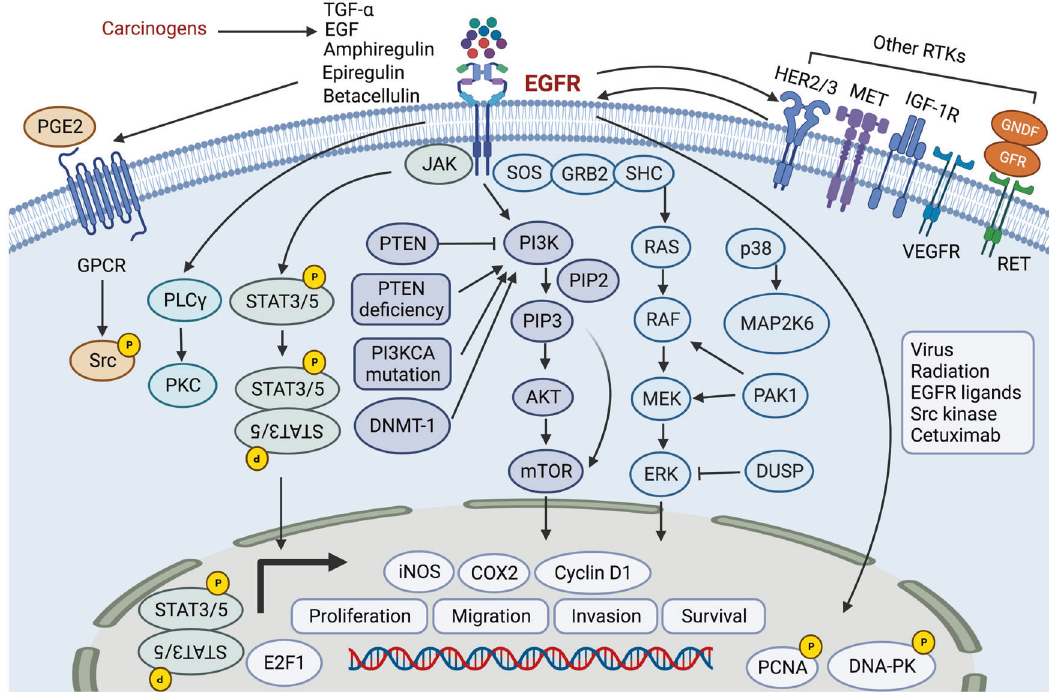
Fig. 2 The EGFR signaling pathway, PI3K/AKT/mTOR pathway, MAPK pathway, STAT pathway, and MET pathway in head and neck cancer. EGFR epidermal growth factor receptor, TGF- α transforming growth factor-alpha, EGF epidermal growth factor, RTKs receptor tyrosine kinases, HER2/3 human epidermal growth factor receptor 2/3, c-MET c ‑ mesenchymal – epithelial transition factor, IGF-1R insulin-like growth factor 1 receptor, PGE2 prostaglandin E2, GPCR G-protein-coupled receptor, PLC γ phospholipase c- γ , PKC protein kinase C, JAK Jenus-activated kinase; STAT3/5, signal transducer and activator of transcription 3/5, PTEN phosphatase and tensin homolog, PI3K phosphoinositide 3-kinase, PIP2 phosphatidylinositol 4,5-bisphosphate, PIP3 phosphatidylinositol 3,4,5-trisphosphate, AKT serine/threonine-speci fi c protein kinase, mTOR mammalian target of rapamycin, DNMT-1 DNA methyltransferase 1, SOS son of sevenless, GRB2 growth factor receptor-bound protein 2, SHC SRC homology domain c-terminal adaptor homolog, ERK: extracellular signal-regulated kinase, MAP2K6 mitogen-activated protein kinase – kinase 6, PAK1 p21-activated kinase 1, DUSP dual-speci fi city phosphatases, PCNA proliferation cell nuclear antigen, DNA-PK DNA- dependent protein